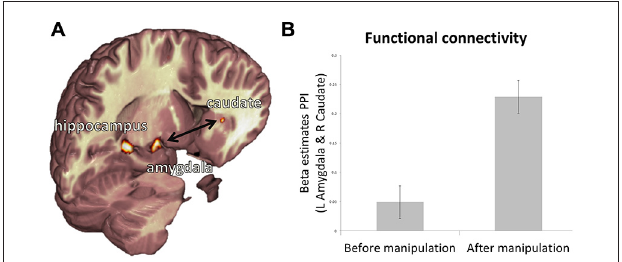
FIGURE 5 | Relationship between representations of value, belief, and reality. (A) Depiction of functional ROIs of the left hippocampus, left amygdala and right caudate. (B) PPI beta estimates reveal that functional connectivity from pre-manipulation session to post-manipulation session is increased between the left amygdala and right caudate. Error bars show within subject standard error of the mean (Cousineau,